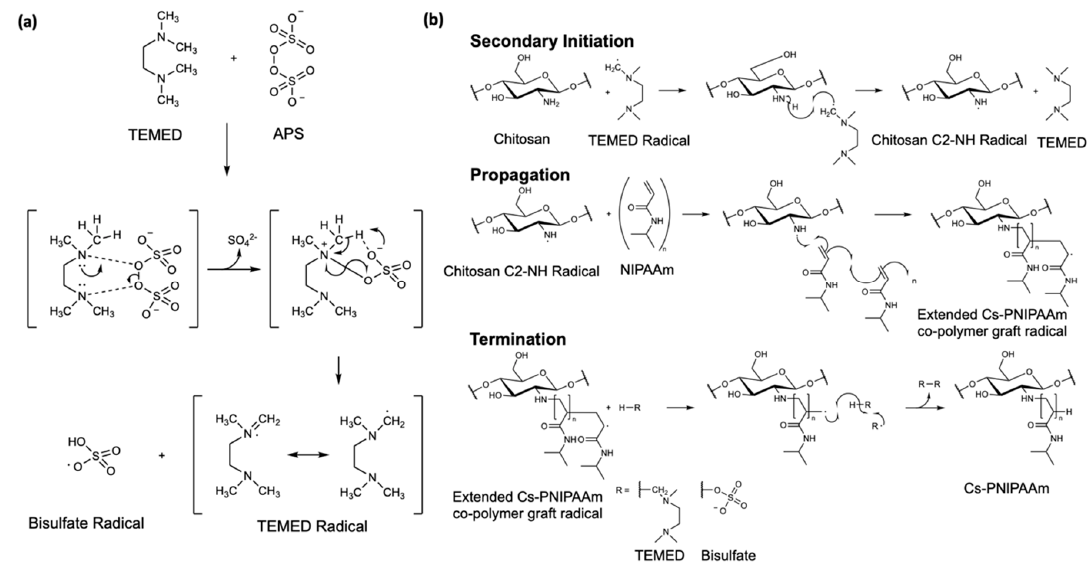
Figure 9. ( a ) Mechanism of primary radical initiation with APS and TEMED. ( b ) Proposed scheme of radial polymerization. Secondary initiation of Cs by TEMED radical, leading to chain reaction propagation with NIPAAm and terminated with a hydrogen atom shift by radical scavenger species (TEMED or bisulfate) to liberate C-2 directed graft of Cs-PNIPAAm copolymer.